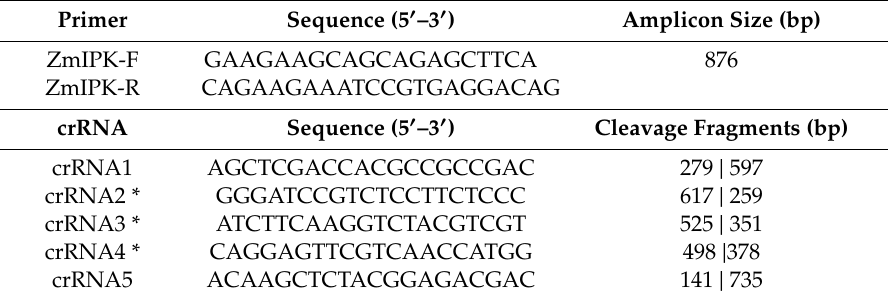
Table 1. List of primers and crispr-RNAs (crRNAs) used for the amplification and mutation of the inositol phosphate kinase gene (IPK) target locus in maize via CRISPR (Clustered Regularly Interspaced Short Palindromic